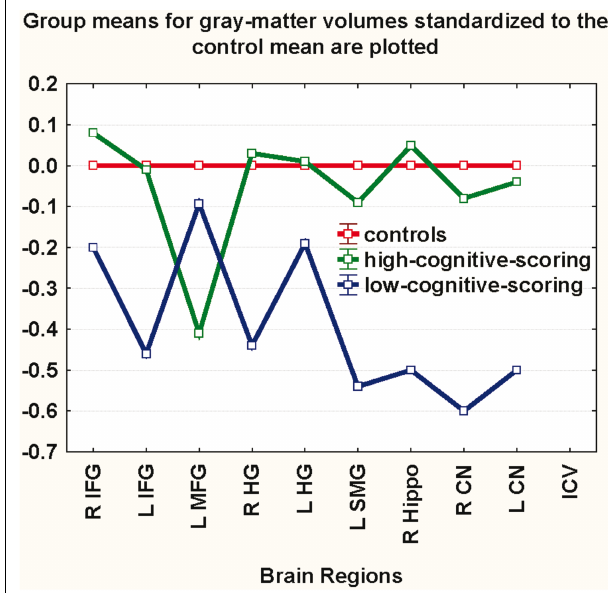
FIGURE 2 | The low scoring subset of relatives had volumetric defi cits in critical brain regions compared to the high scoring subset. Regional gray-matter-volumes (right and left combined) for each group were z-transformed to the control mean. Group-means of the z -scores are plotted on the y -axis in the low-scoring and the high-scoring groups (see text for description of approach to this classifi cation). HG, Heschl’s gyrus; SMG, supramarginal gyrus; MFG, middle frontal gyrus; IFG, inferior frontal gyrus; Hippo, hippocampus; CN, caudate